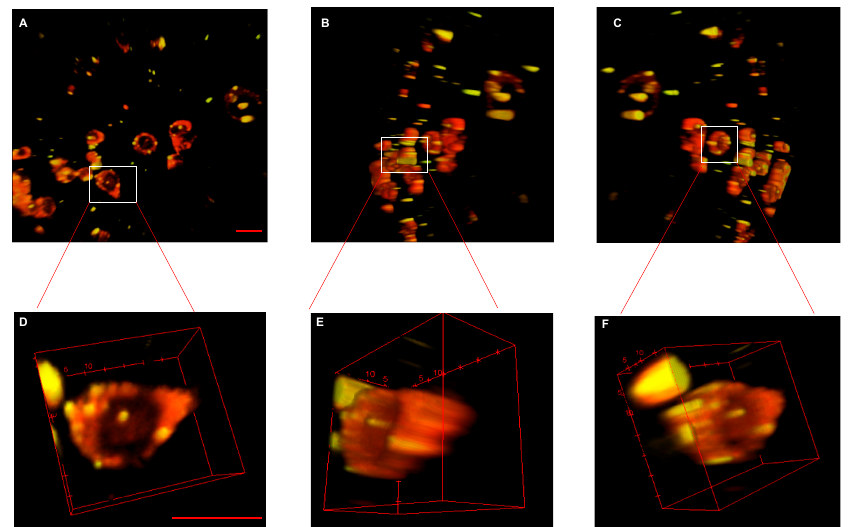
Figure 6. Multi-photon pictures of cells after exposure to bi-HNTs, pictures were analyzed with NIH Image J. Cell membranes were stained by DiR dye and exhibited a red color at wavelength of 850 nm. At this wavelength FITC exhibited a yellow color. The 3D pictures were captured at 36 microns in z with a 2 micron separation in each z step. ( A ) is the front view of the 3D picture for multiple cells, ( B ) and ( C ) are side views of the 3D picture. ( D – F ) are the zoom in pictures of the marked cell. (Scale bar with 50 μ m)